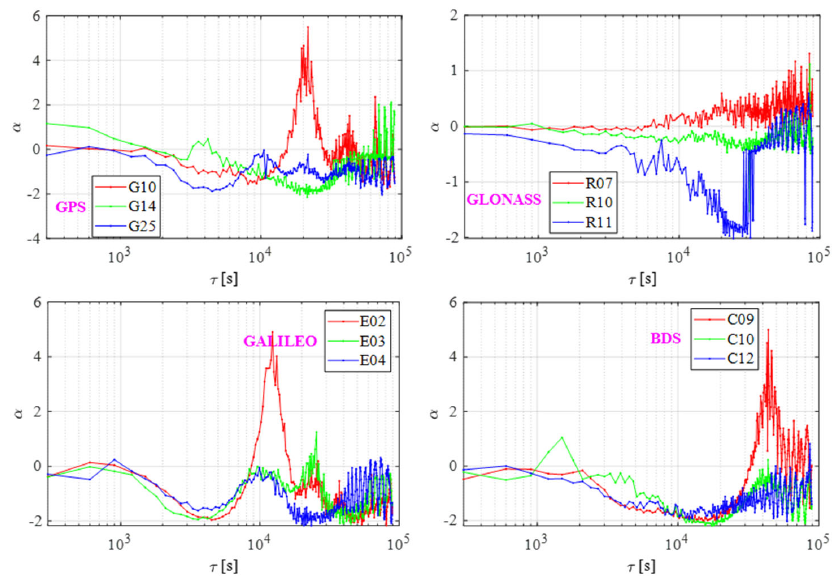
Figure 8. Noise of GNSS satellites ( a ) GPS, ( b ) GLONASS, ( c ) GALILEO, ( d ) BDS.